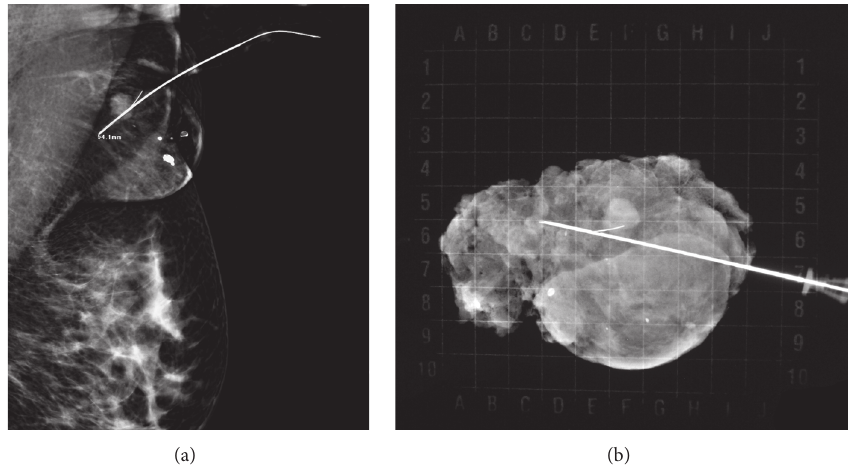
Figure 3: Wide-needle localized excision (a) with intraoperative radiography of surgical specimen